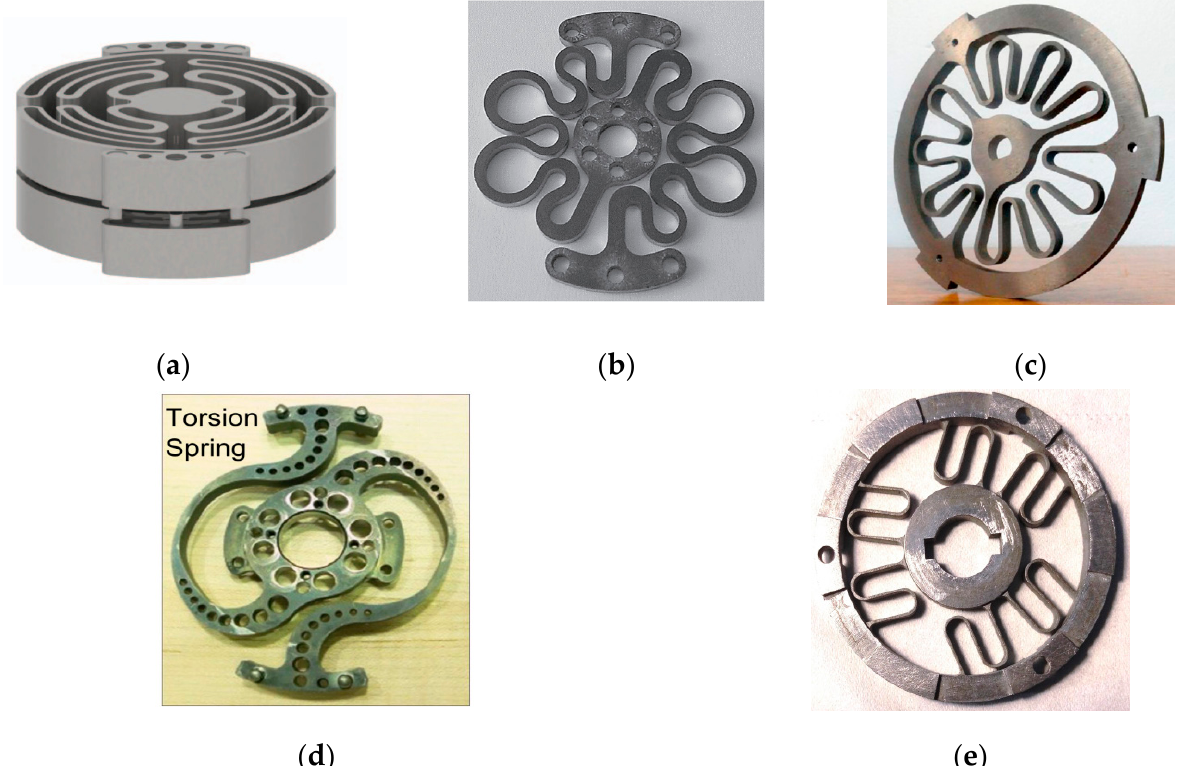
Figure 1. Patterns of compliant elements for rotary series elastic actuators. ( a ) two identical custom torsion springs [16]. ( b ) compact torsion spring, adapted with permission from Ref. [17]. 2023 Copyright Omar Al-Dahiree. ( c ) customized torsion spring, adapted with permission from Ref. [18]. 2023 Copyright Omar Al-Dahiree. ( d ) torsion spring for Valkyrie’s series elastic actuator, adapted with permission from Ref. [19]. 2023 Copyright Omar Al-Dahiree. ( e ) torsional elastic module [22,23].